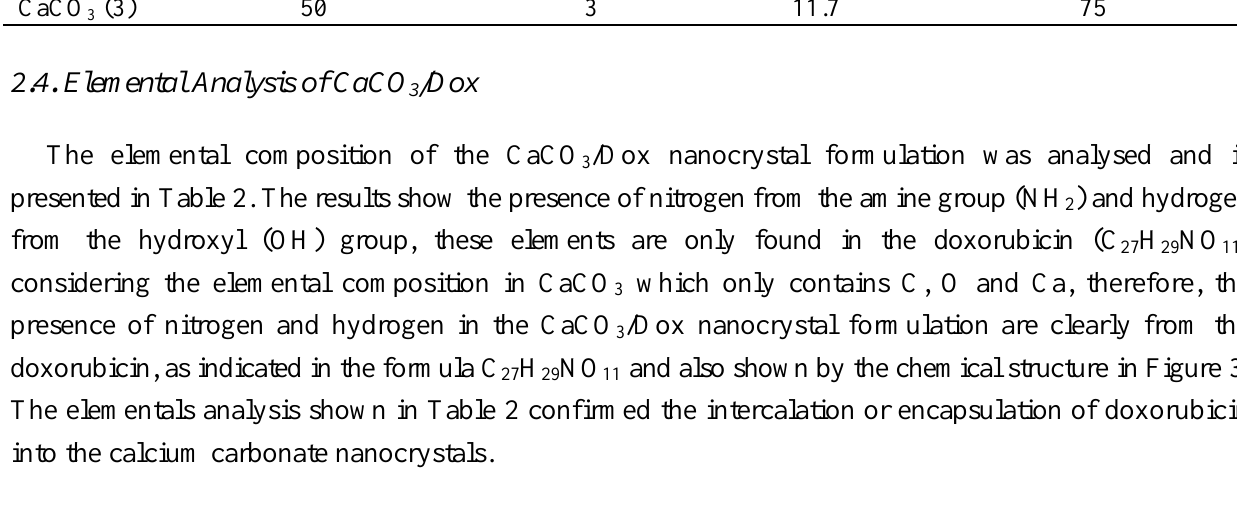
Table 2. Elemental composition of drug-loaded calcium carbonate